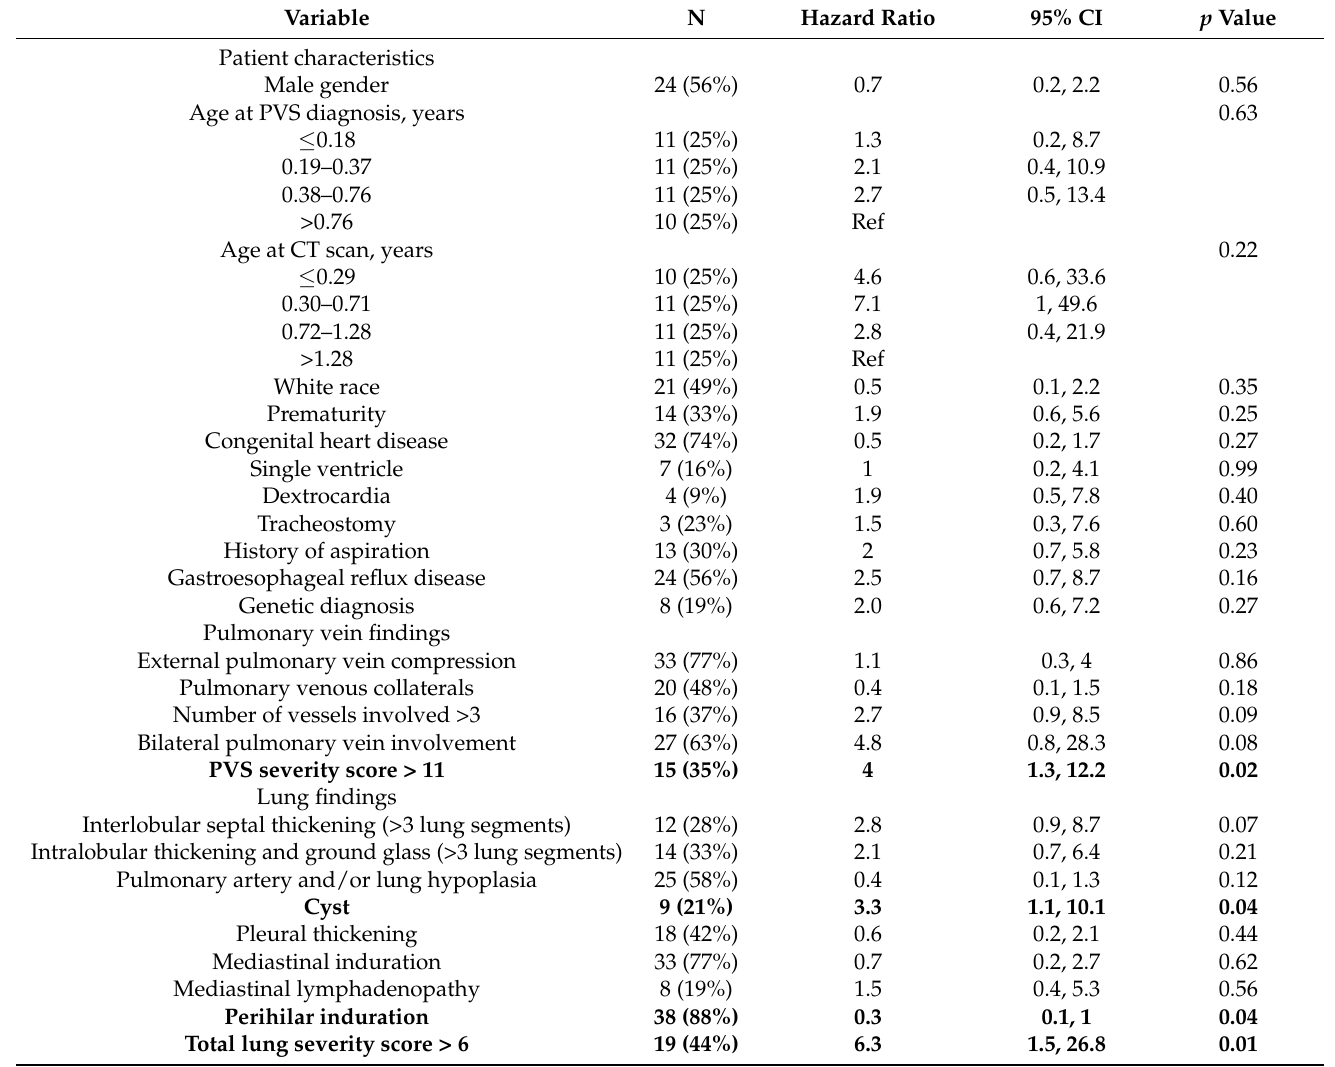
Table 4. Univariate Cox regression analysis of variables associated with time to